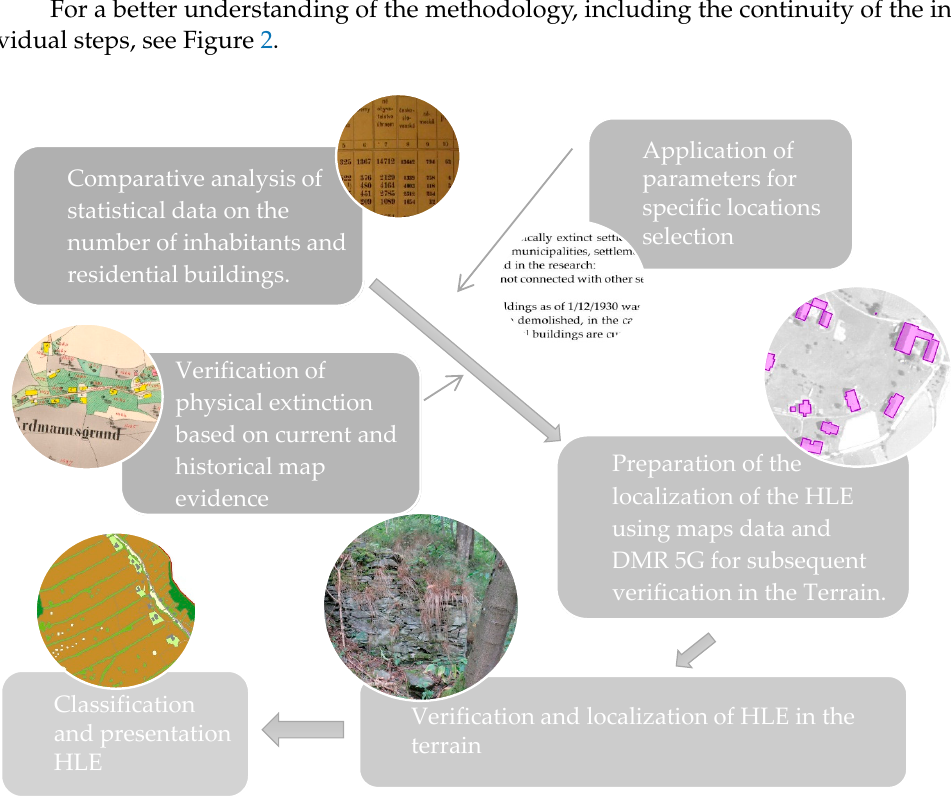
Figure 2. Graphical representation of methodology.